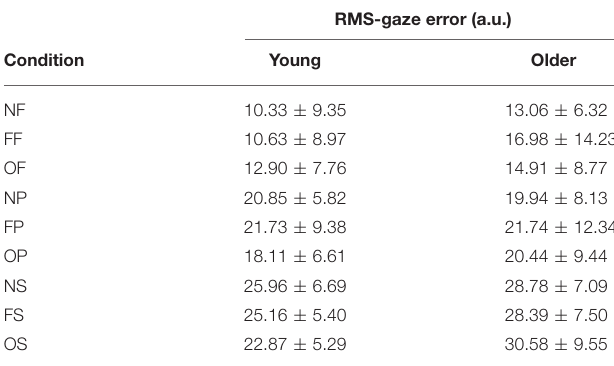
TABLE 4 | RMS of gaze subtracted from target position (in arbitrary units) for young ( n = 12) and older ( n = 12) participants during different visual scene conditions.